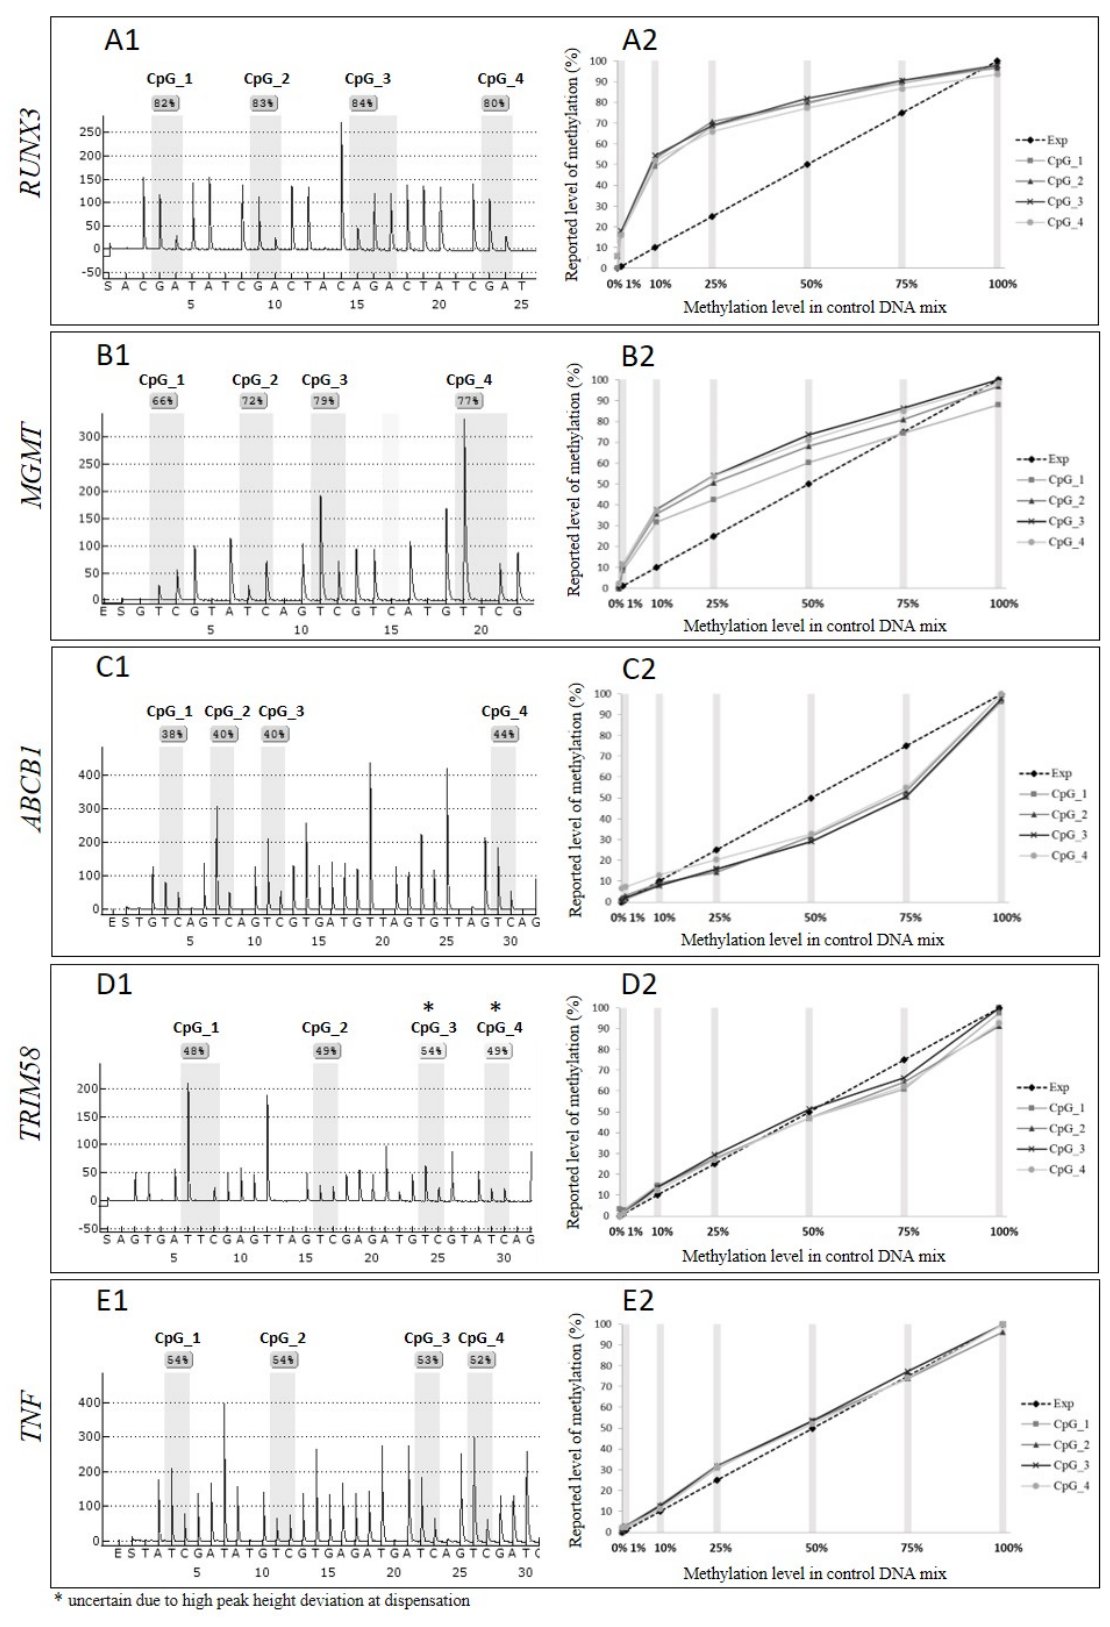
Figure 1. Comparison of the reported and expected methylation levels for pyrosequencing assays, including panel ( A1 , A2 )— UNX3 gene, ( B1 , B2 )— MGMT , ( C1 , C2 )— ABCB1 , ( D1 , D2 )— TRIM58 and ( E1 , E2 )— TNF . Panels denoted with 1 describe the reported methylation levels by pyrosequencing